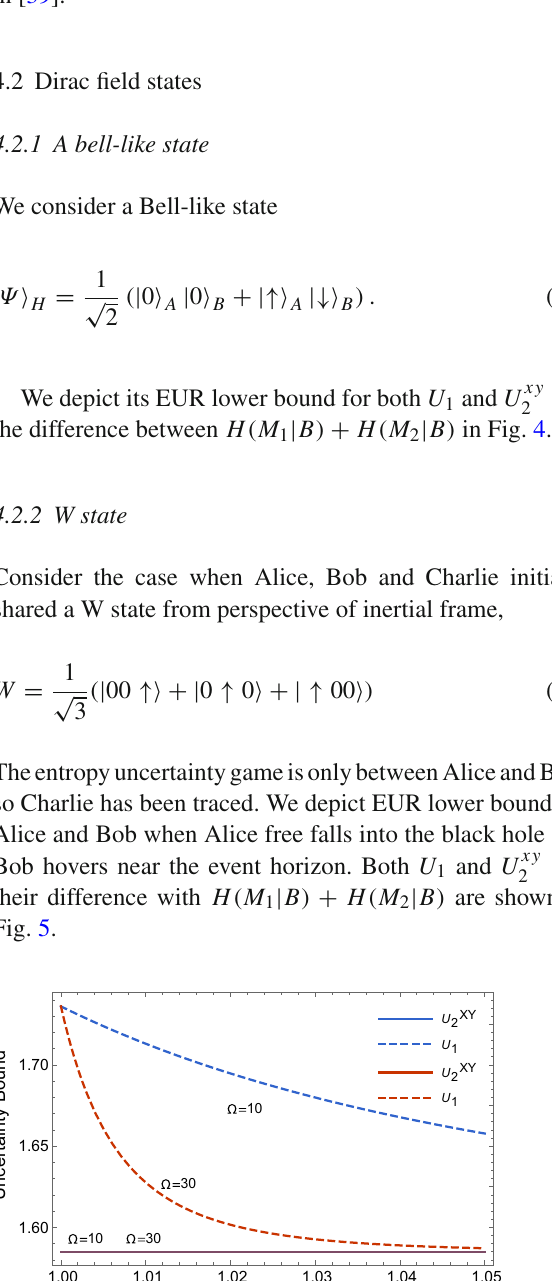
Fig. 3 Given Ω = ω/ T H = 10 or 30, U xy